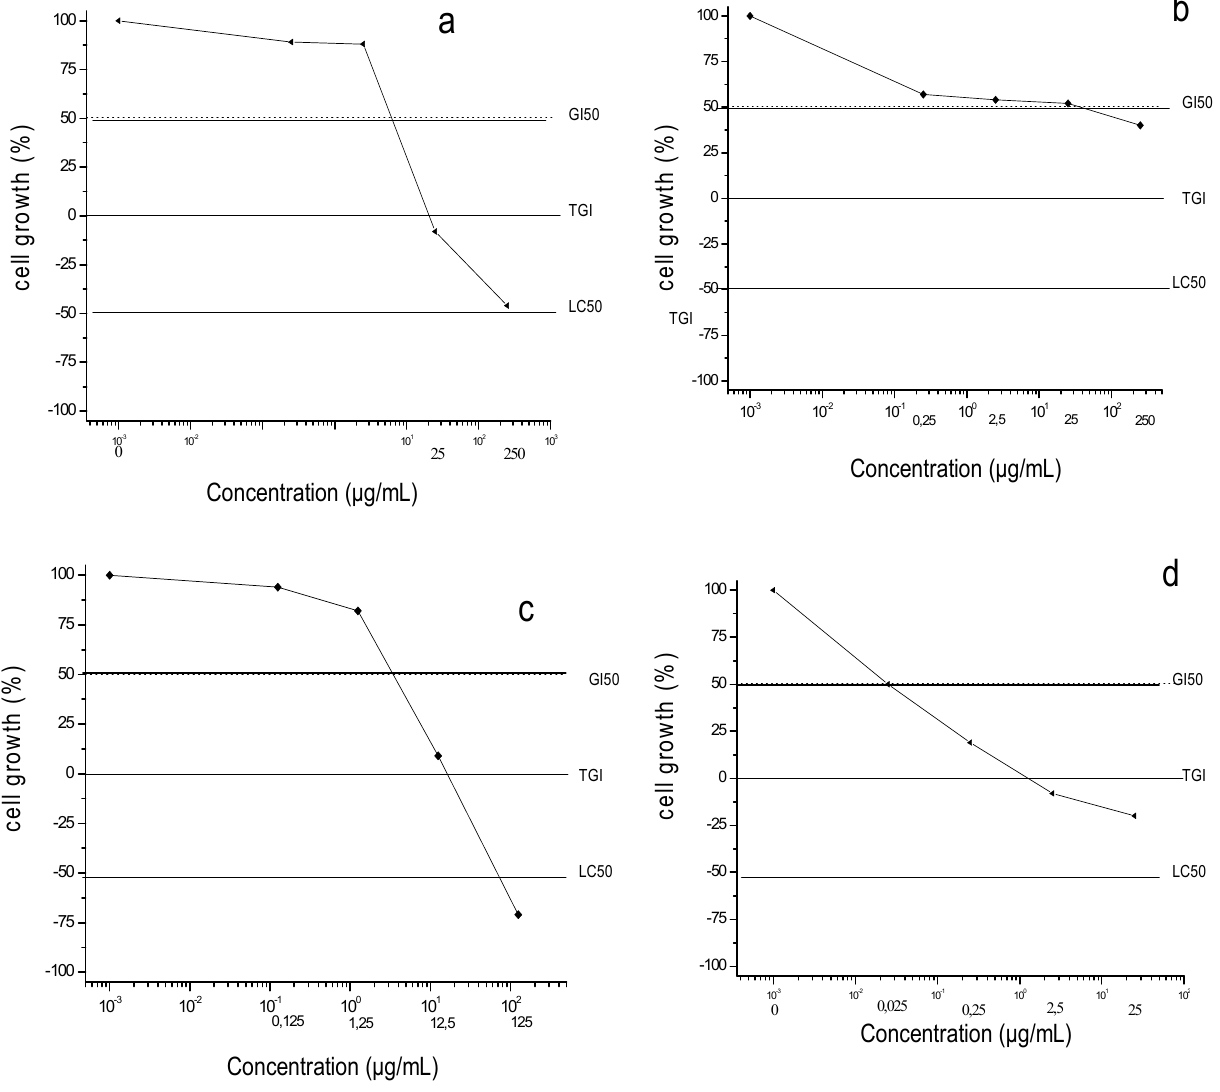
Figure 2. Antiproliferative activities in PC-3 cell line: ( a ) crude leaf extracts; ( b ) crude fruit extracts; ( c ) cardamonin and ( d ) doxorubicin after 48h treatment. G50: concentration necessary to inhibit 50% of growth; TGI: concentration necessary to inhibit 100% of growth and LC50 concentration necessary to be lethal 50% of cell